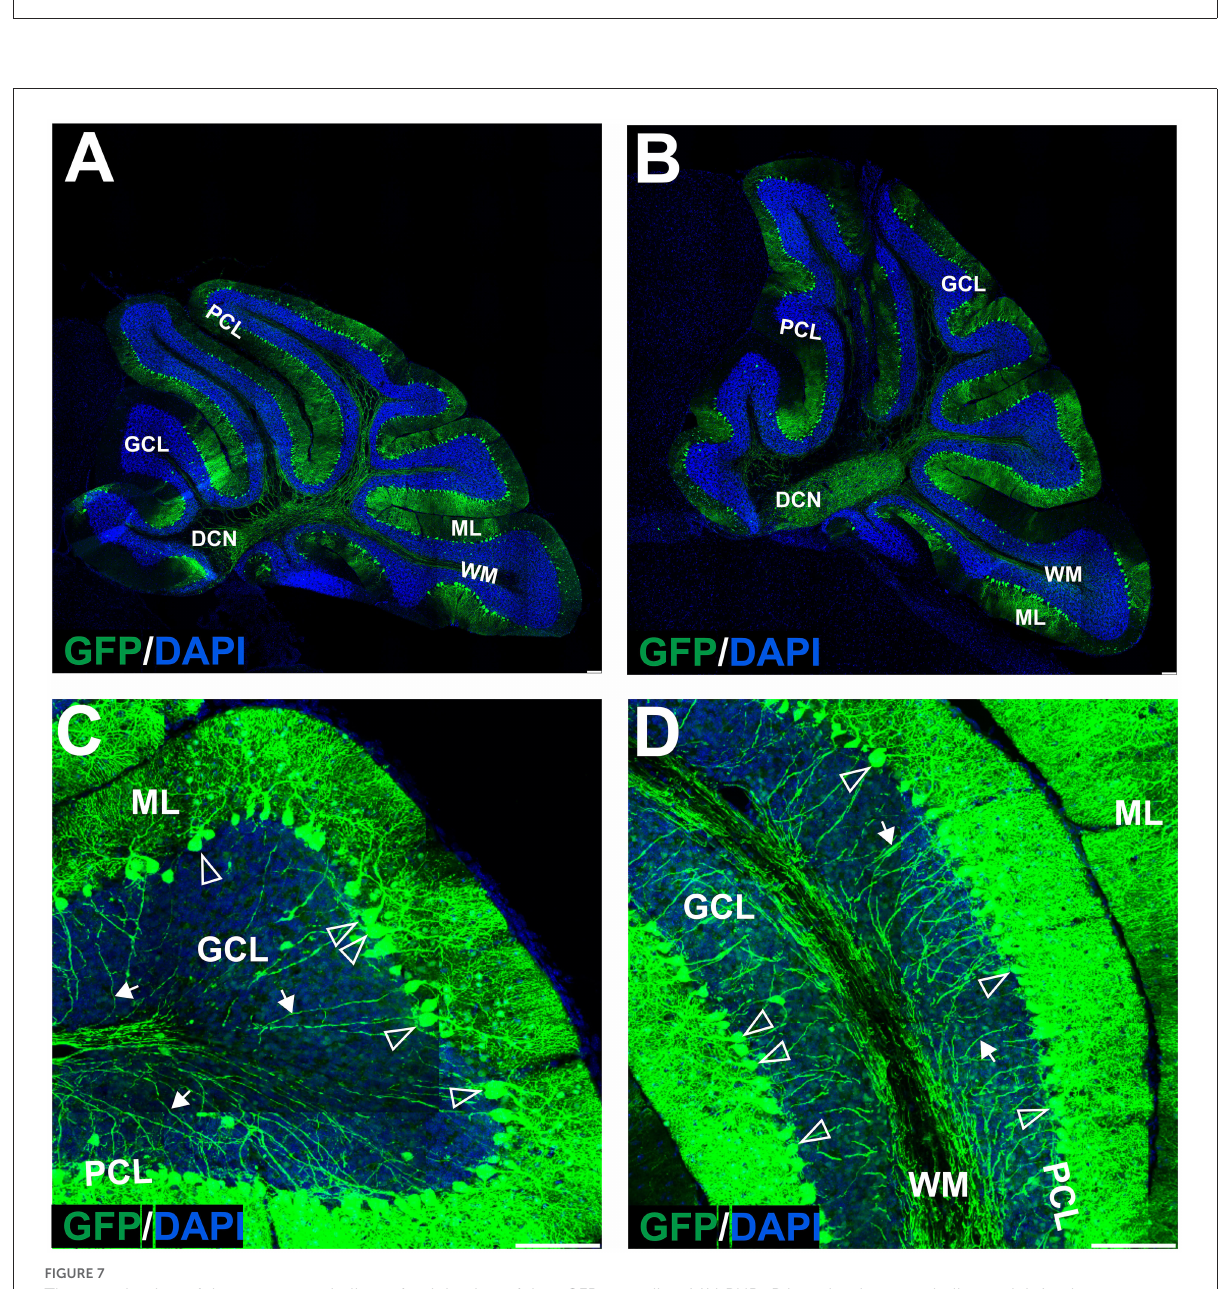
FIGURE7 The transduction of the mouse cerebellum after injection of the eGFP-encoding AAV-PHP.eB into the deep cerebellar nuclei. A robust green signal has been observed throughout the cerebellar ML and was localized almost exclusively in Purkinje cells on the sagittal sections at 4 (A,C,D) and 7 (B) weeks after injection. Higher magnification of the transduction pattern was shown in (C,D) , 4 weeks after injection. eGFP signal was observed in all compartments of the PC, including bodies and dendritic trees (unfilled arrowheads), and axons (arrows). DCN, deep cerebellar nuclei; GCL, granule cell layer; ML, molecular layer; PCL, Purkinje cell layer; WM, white matter. Sagittal section. Bars: 100 µ m in the lower right corner of images. Purkinje cell transduction efficiency at DCN injection: 93% ( N = 3 animals, see Figure